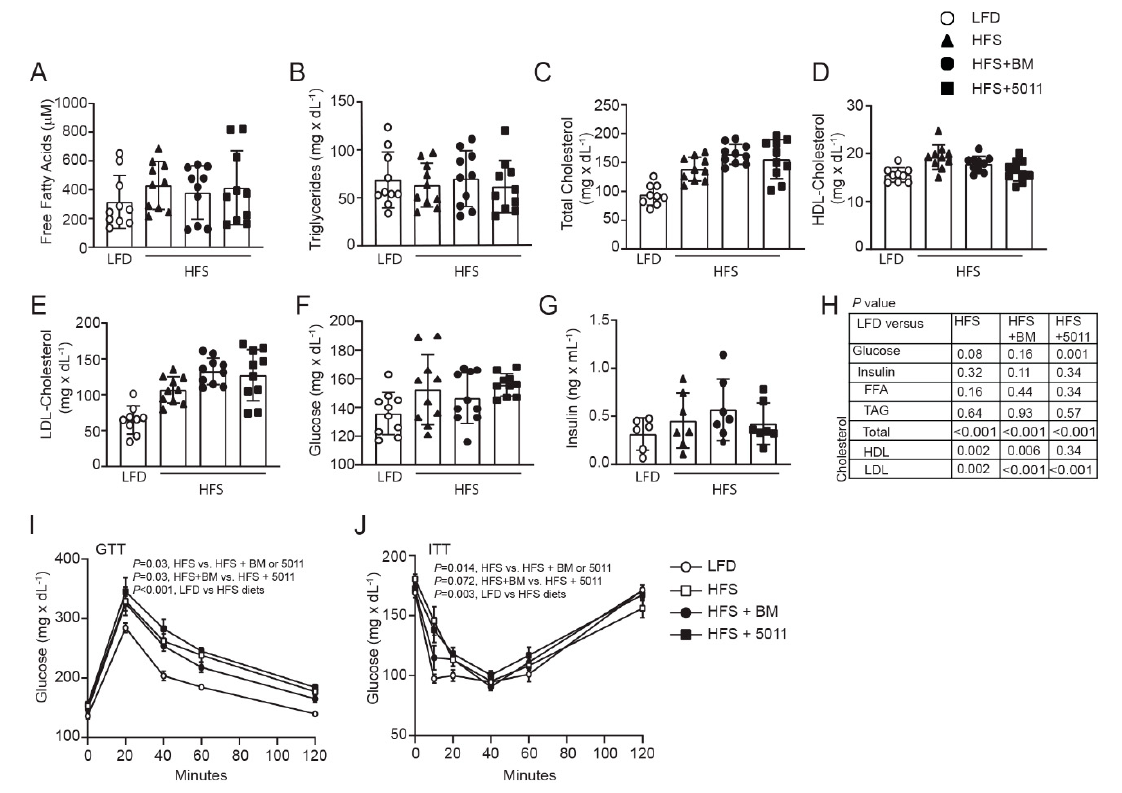
Figure 2. Effects of HFS diets on serum lipids and glucose homeostasis in the female mice. Serum free fatty acids ( A ) and triglycerides ( B ) were not a ff ected by the HFS diets although total ( C ) and low-density lipoprotein (LDL) ( E ), but not high-density lipoprotein (HDL) ( D ) cholesterol were increased with the HFS diets. Fasting glucose ( F ), but not insulin ( G ) was increased by the HFS diet. Glucose levels were unchanged from the low-fat-diet (LFD) group with botanical supplementation ( F ), but glucose tolerance ( I ) and insulin sensitivity ( J ) was impaired in all HFS-fed groups. Statistical significance ( H ) for each panel was set at p < 0.05, ( n = 10 per group), variability is expressed as mean ± SD.